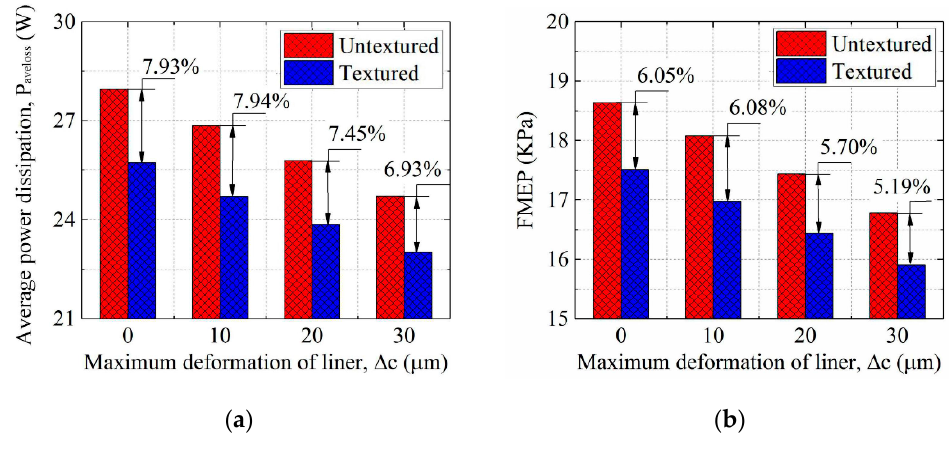
Figure 12. Reduced percentages of the average power dissipation and friction mean effective pressure (FMEP) value after texturing grooves on the ring for different maximum liner deformations: ( a ) Average power dissipation; ( b ) FMEP value.